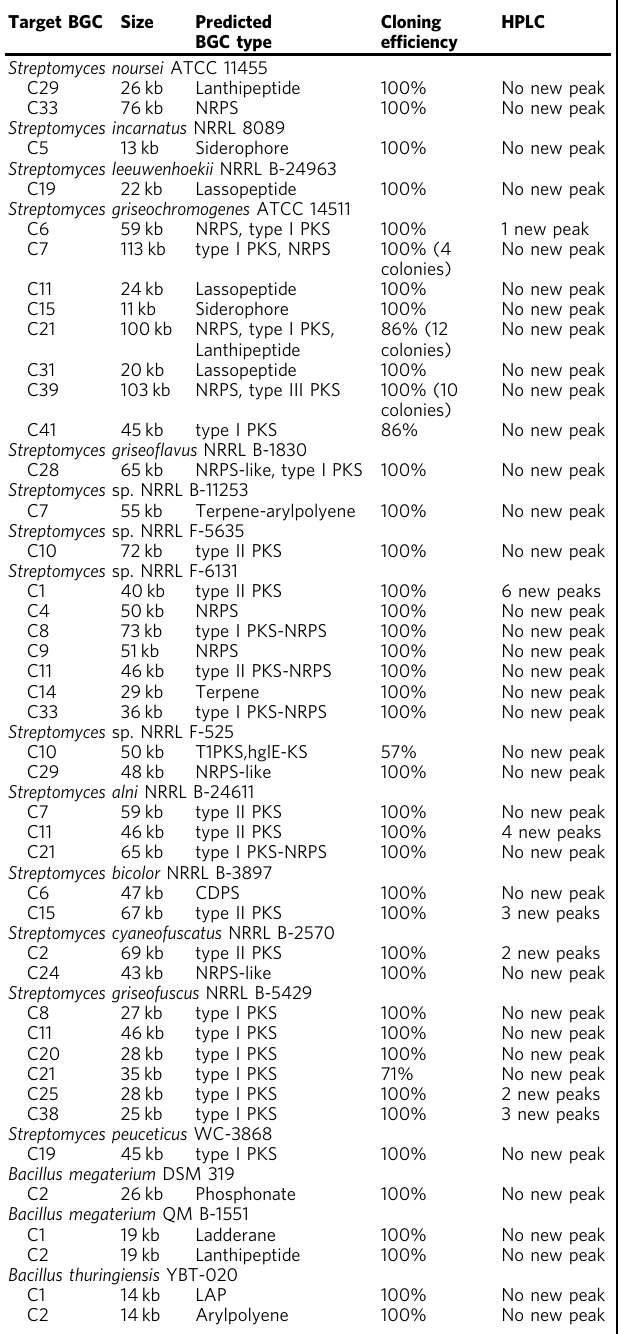
Table 1 Summary of the results from the 43 uncharacterized BGCs cloned by